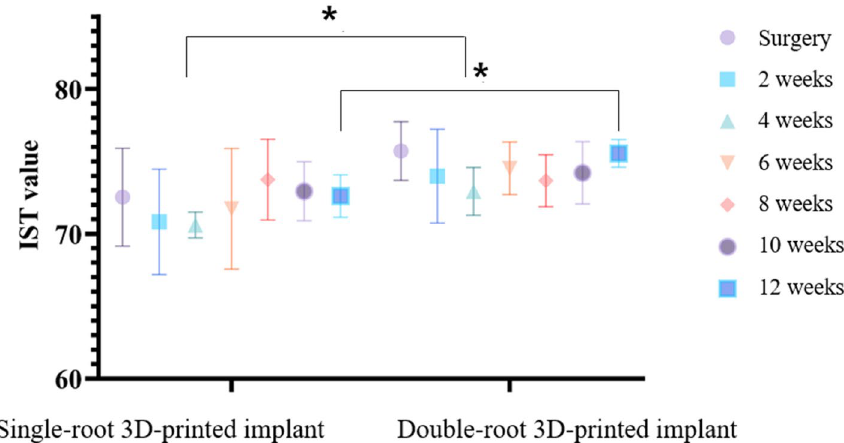
Figure 2. Implant stability test (IST) values of single- and double-root 3D-printed implants. The IST values were significantly greater for the double-root 3D-printed implants at 4 and 12 weeks than for the single-root